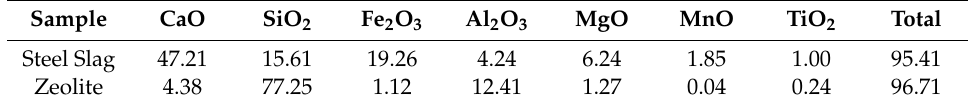
Table 1. Chemical composition of raw materials (wt.%).